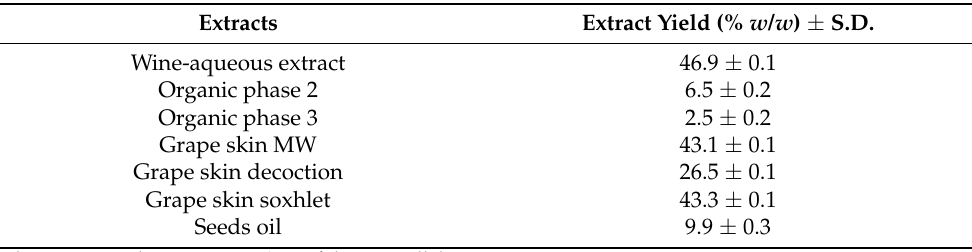
Table 1. Extraction yields calculated as % w / w for wine-aqueous extract, organic phase 2, organic phase 3, grape skin MW, decoction, and soxhlet and seeds oil.